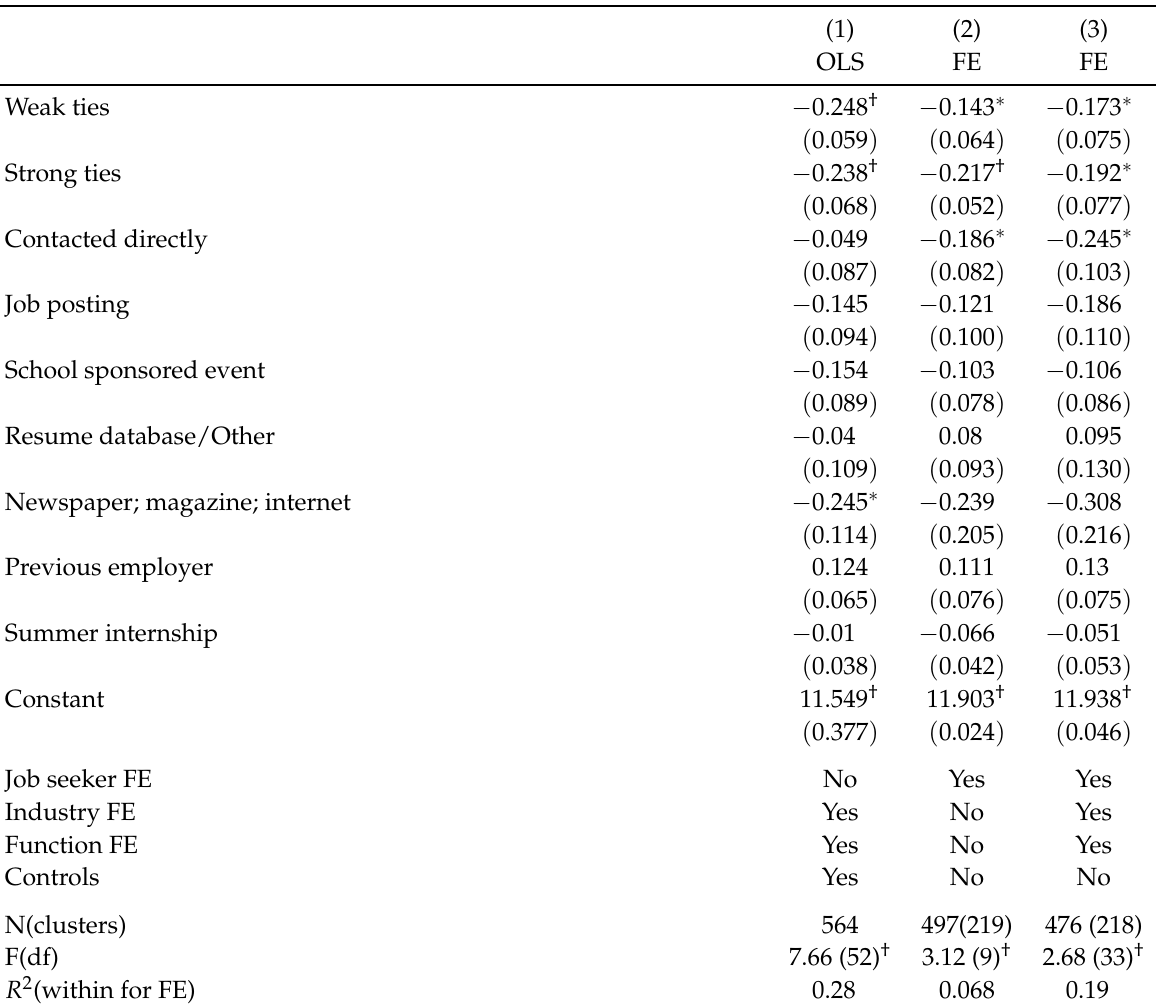
Table 2: Regression Coefficients Predicting Ln(Total